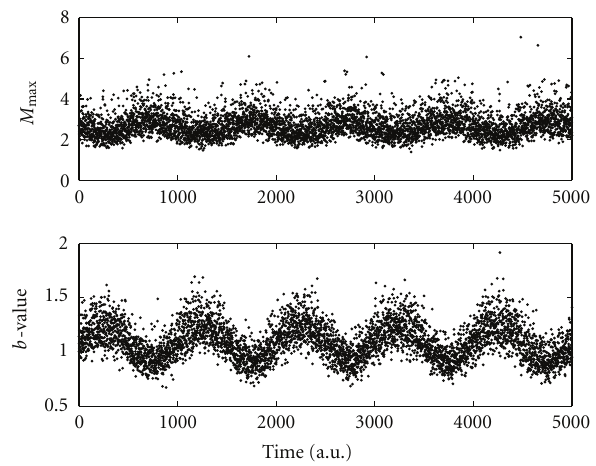
Figure 1: An example of realization of the SEM model of a seismic regime; (a) maximal magnitude values M max ; (b) the b -values. On an abscissa axis, the arbitrary time units are given (500 events in average in each).